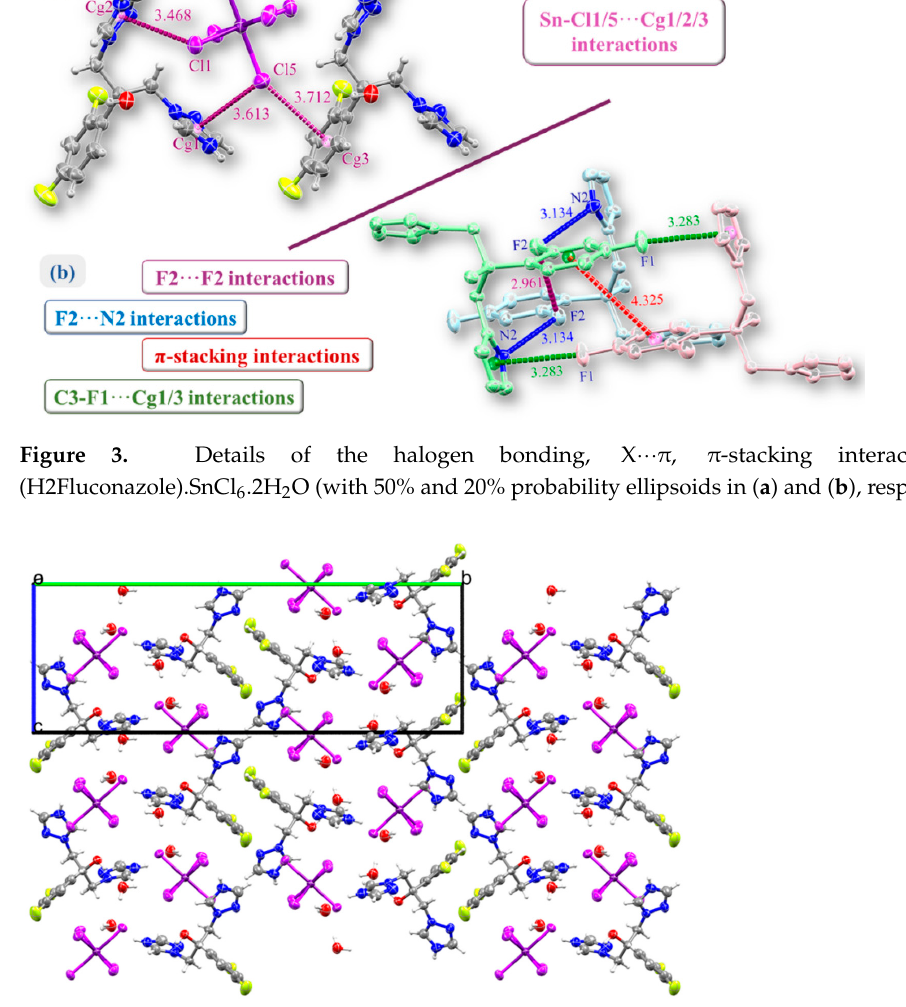
Figure 2. Hydrogen bond interactions in (H2Fluconazole).SnCl 6 .2H 2 O.